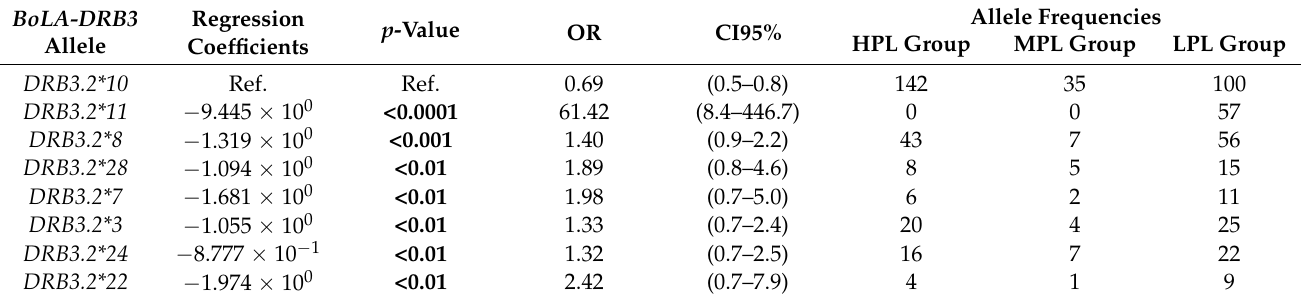
Figure 3. BoLA-DRB3 allele frequencies in high, medium, and low PVL groups. Graph showing the transition of highly frequent BoLA-DRB3 alleles from 598 cattle with different BLV PVLs, as genotyped by RFLP-PCR. LPL: low PVL group, MPL: medium PVL group, HPL: high PVL group. Table 4. Multivariate negative binomial regression analysis and Odds ratios (ORs) between BLV-associated PVLs and Bo LA-DRB3